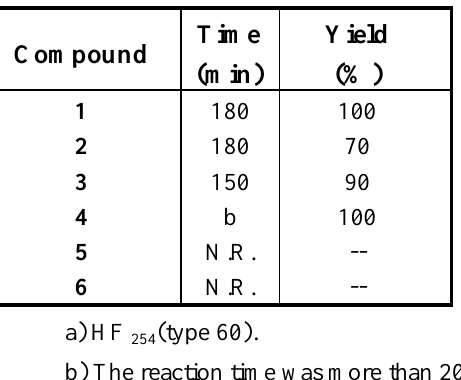
Table 3. Solid phase oxidation of benzoins on silica gel a in a sand bath (140 o C).